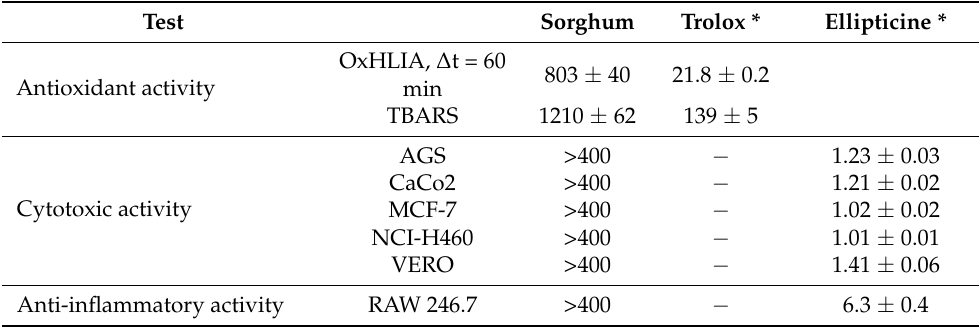
Table 2. Antioxidant activity (IC 50 ; µ g mL − 1 ), cytotoxic and anti-inflammatory activity (GI 50 , µ g mL − 1 ) of sorghum dye.